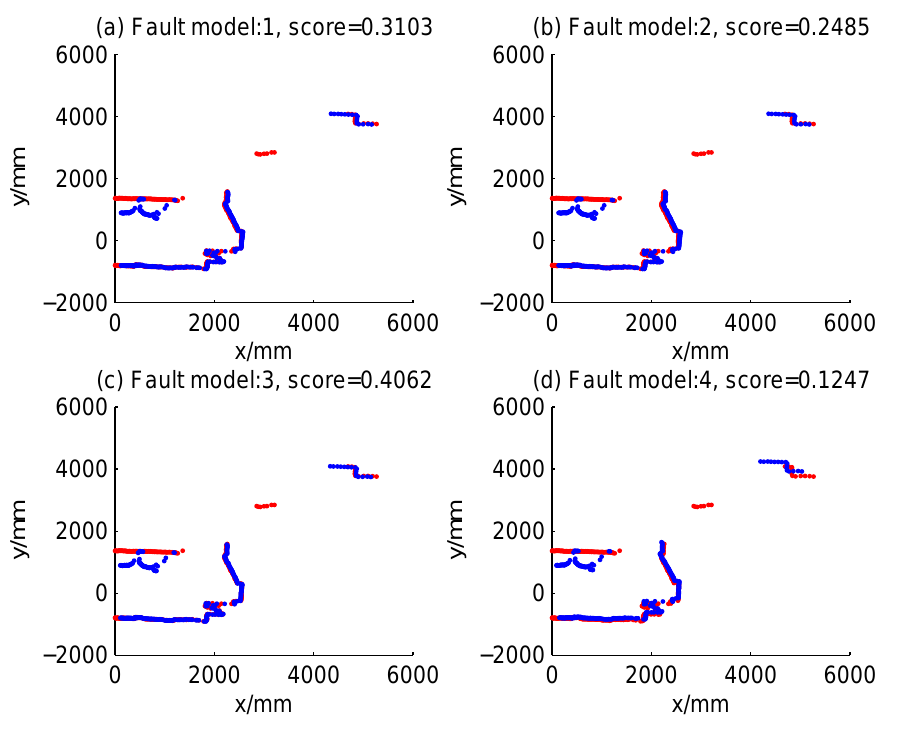
Figure 9. Case 1a: No faults, fault model = 1 (time Step